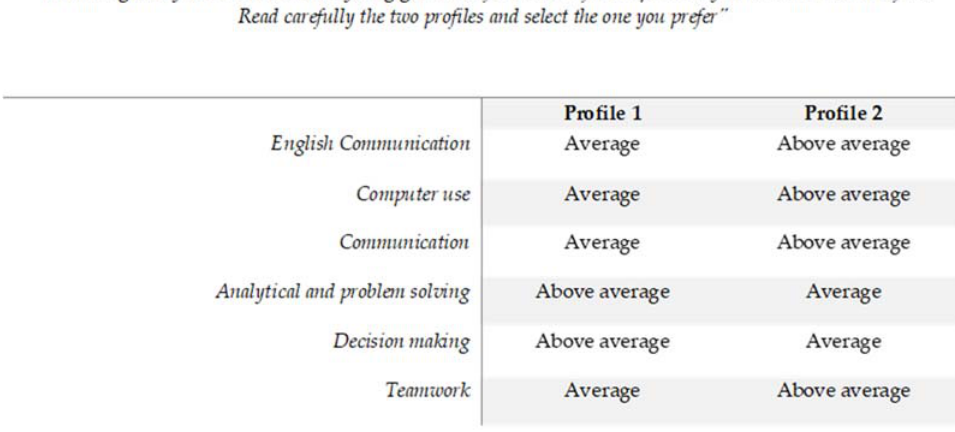
Figure 1. Example of a task in the conjoint questionnaire.